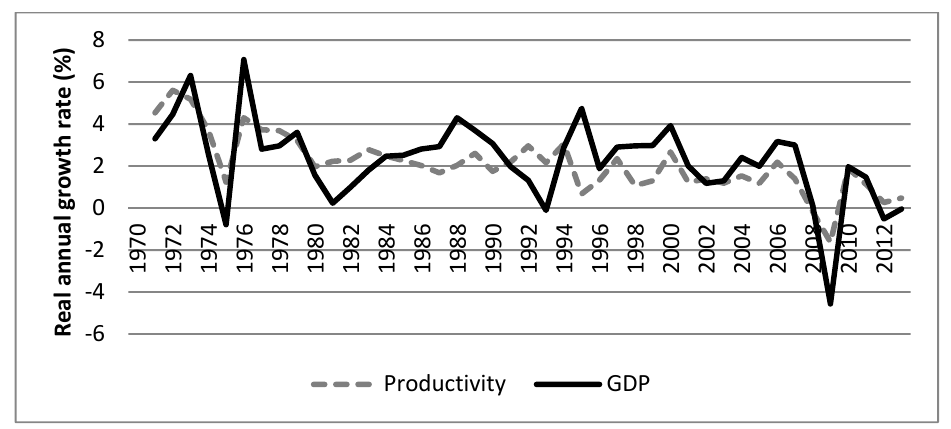
Figure 2. GDP and labour productivity (GDP/hours worked) growth rates (EU15)